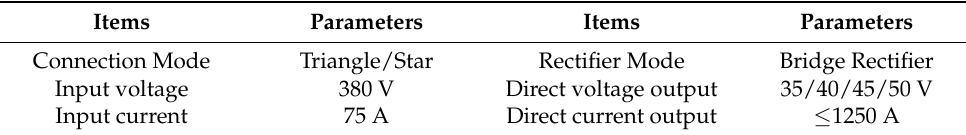
Table 4. Main parameters of the furnace transformer.